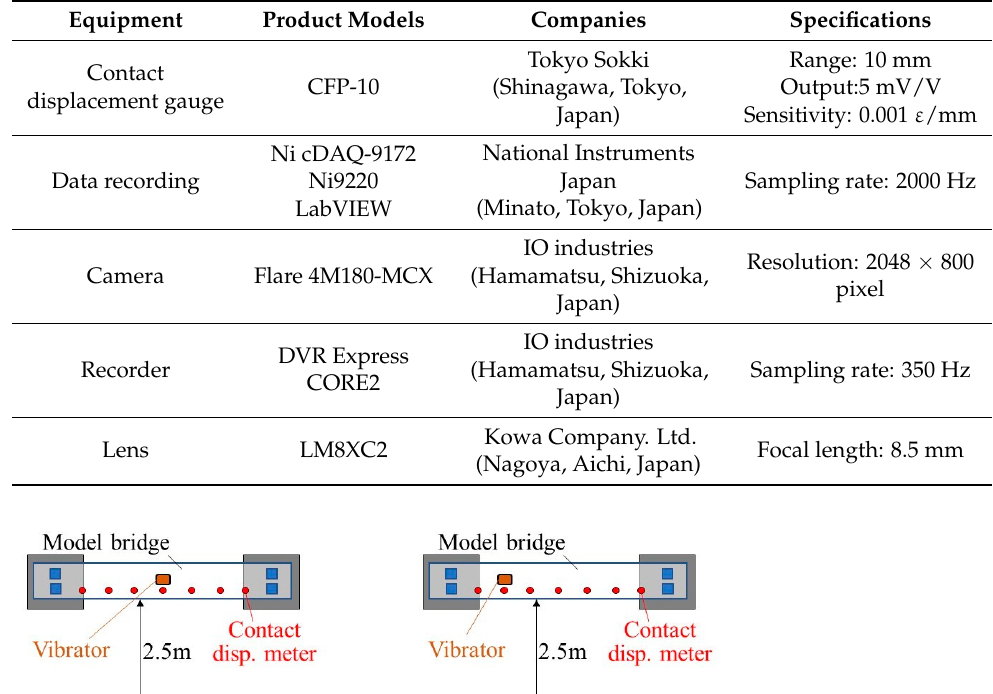
Table 2. Specifications of the measuring equipment.